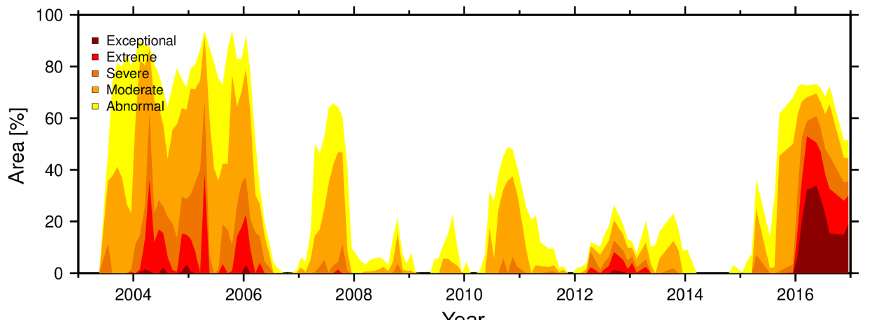
Figure 11. Percentage of drought-affected area for the 6-month DSIA (–) considering the different drought severity classes. Application on real GRACE-TWSC over South Africa from 2003 to